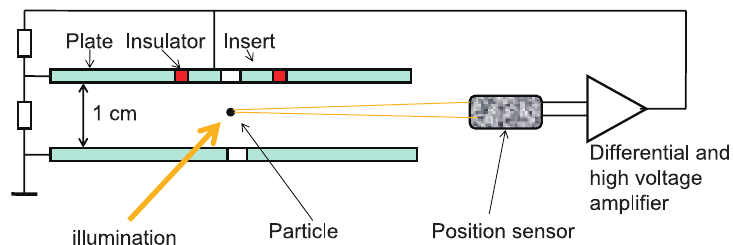
Fig. 15 Capacitor for measurement of the photophoretic force. The upper plate of the capacitor has a circular insert, which is kept at a higher voltage, stabilizing the particle horizontally in the center. The vertical stabilization is done with a position- sensitive